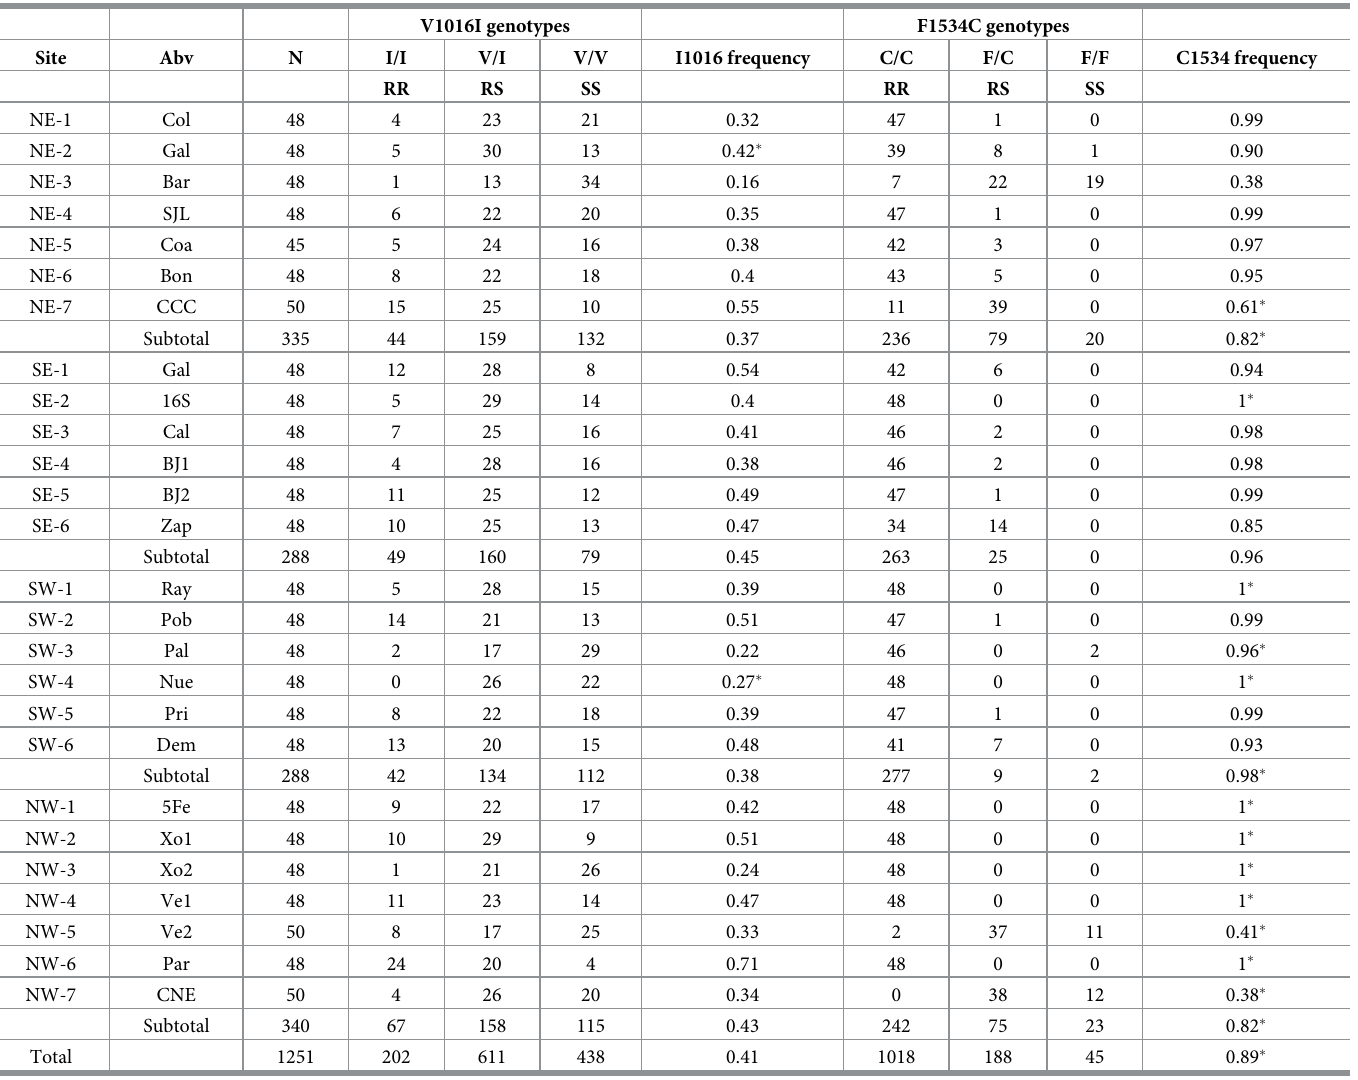
Table 3. Genotype counts and allele frequencies for two kdr -associated substitutions (V1016I and F1534C) from Aedes aegypti collected at 26 sites in Tapachula. RR = homozygote resistant, RS = heterozygote, and SS = homozygote susceptible. � indicates a lack of Hardy-Weinberg equilibrium. V1016I genotypes F1534C